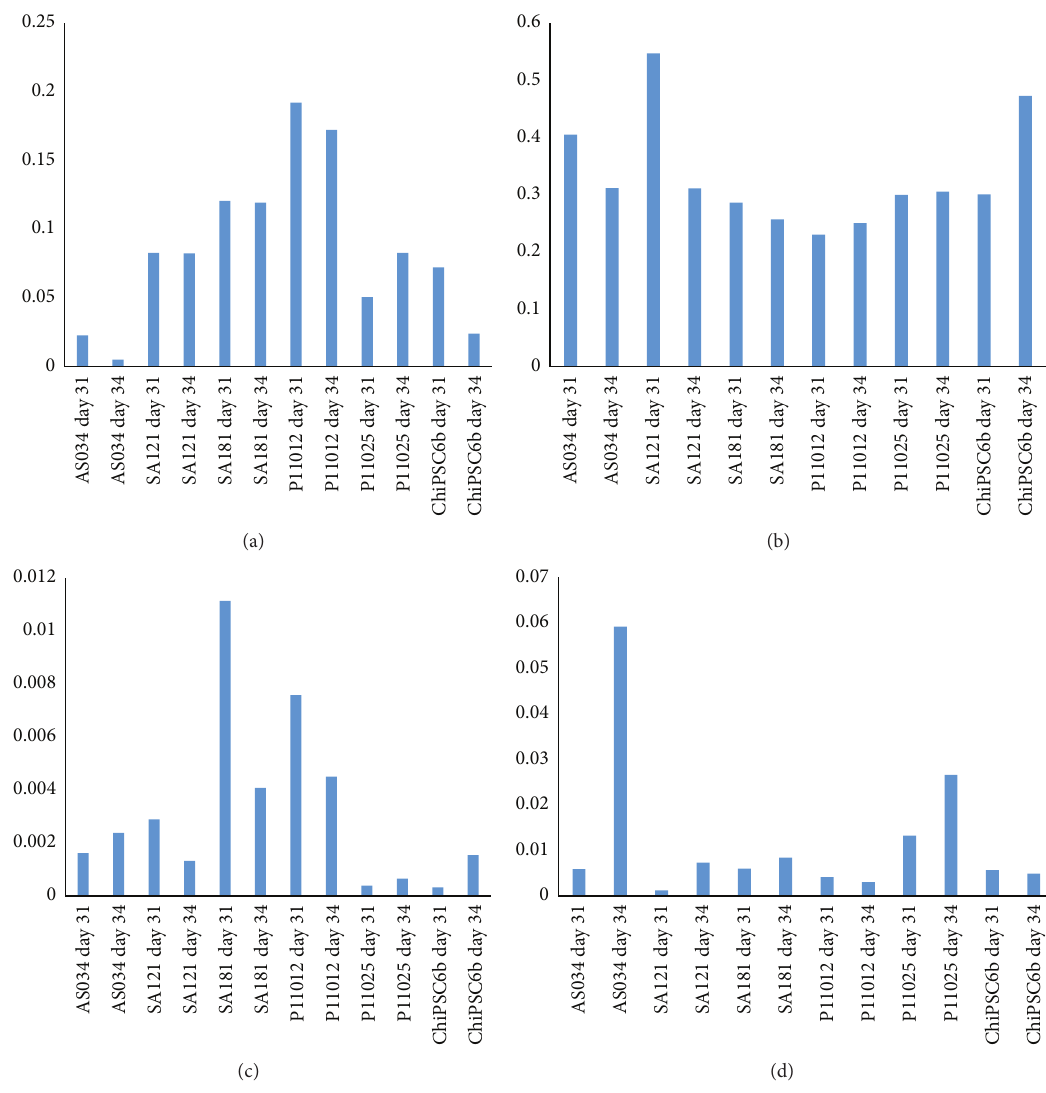
Figure 15: Bar graph showing the RNA expression levels of the drug transporters (a) SLC10A1 (NTCP), (b) ABCC2 (MRP2), (c) SLCO1B1 (OATP1B1), and (d) ABCB11 (BSEP). The 𝑥 -axis indicates the hPSC lines at days 31 and 34 of the hepatic differentiation. The 𝑦 -axis indicates